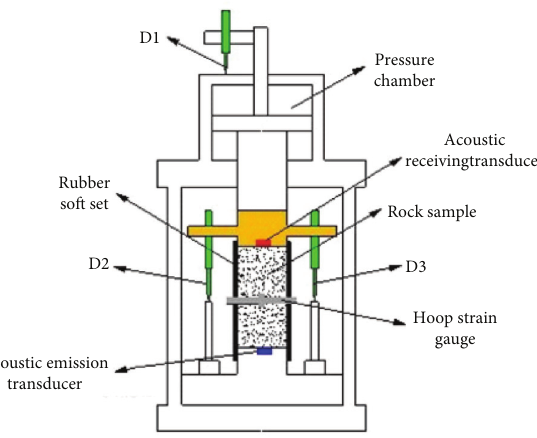
Figure 10: Schematic diagram of ultrasonic transmit-receive de- vice